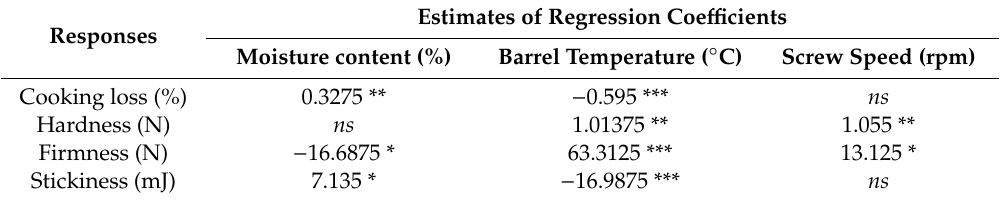
Table 3. Significant estimates of the regression coefficients of the model for the different responses.